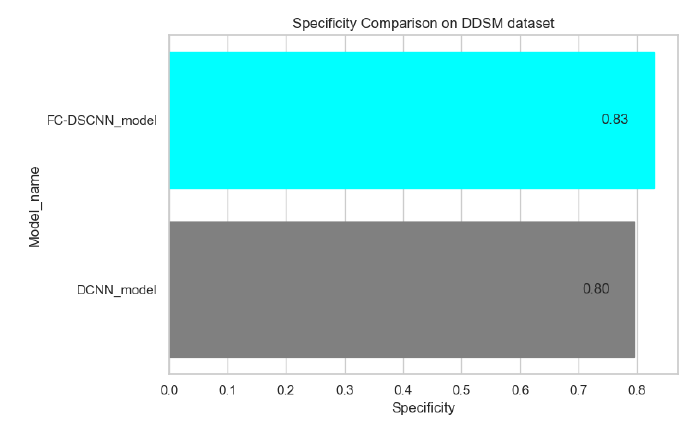
Figure 15. Specificity comparison on the DDSM